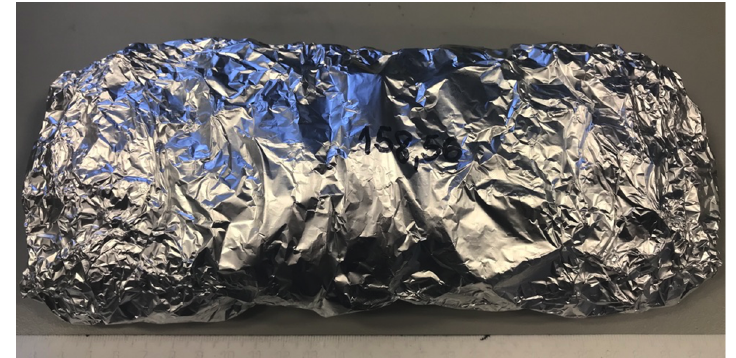
Figure 3. Sugarcane bagasse sample wrapped in aluminum foil.